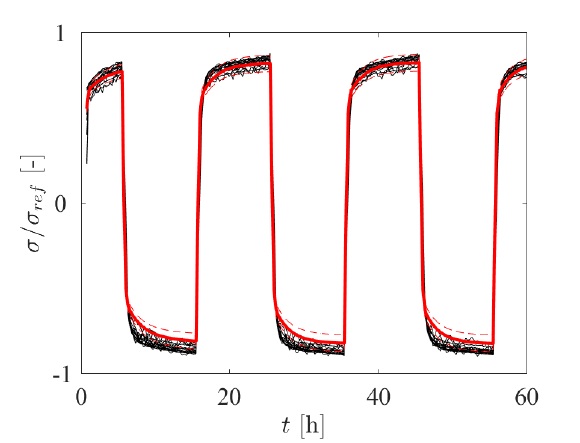
Figure 7. Comparison of experimental observations (black) with model responses (red) corresponding to the identified parameters’ distribution in a form of mean value ± standard